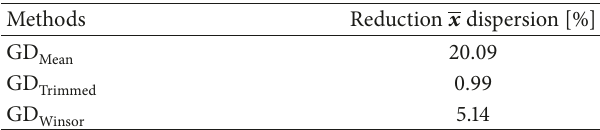
Table 14: Log-normal with 20 points.